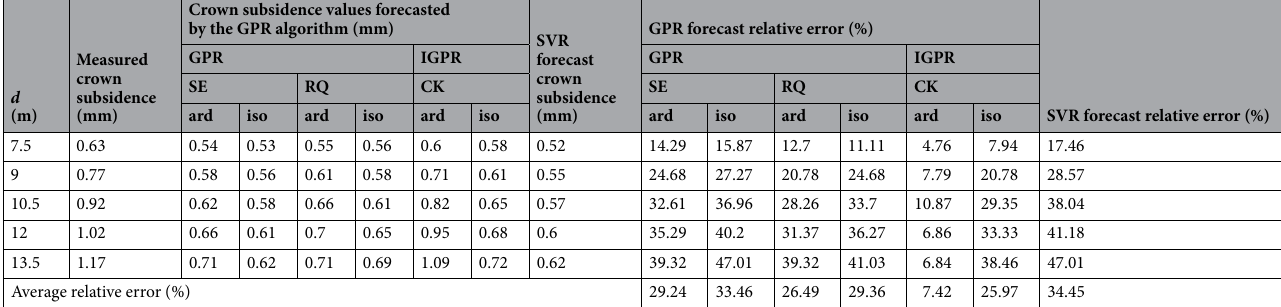
Table 10. Crown subsidence values forecasted by the identified geomechanical parameters of monitoring section LK59 +